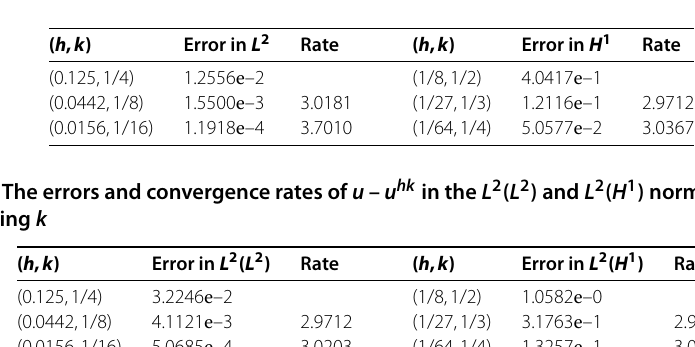
Figure 5 The exact solution of v at t = 1.